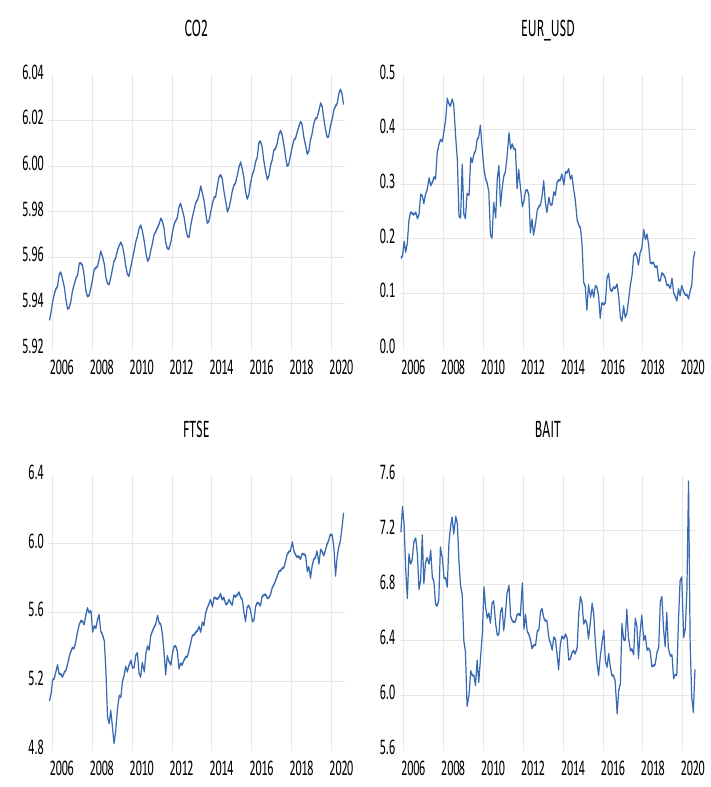
Figure 1. The evolution of the model variables.